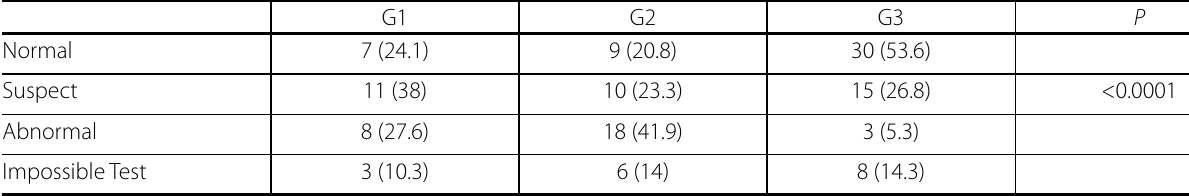
Table 3. General Result of the Denver II Assessment (n = 128).